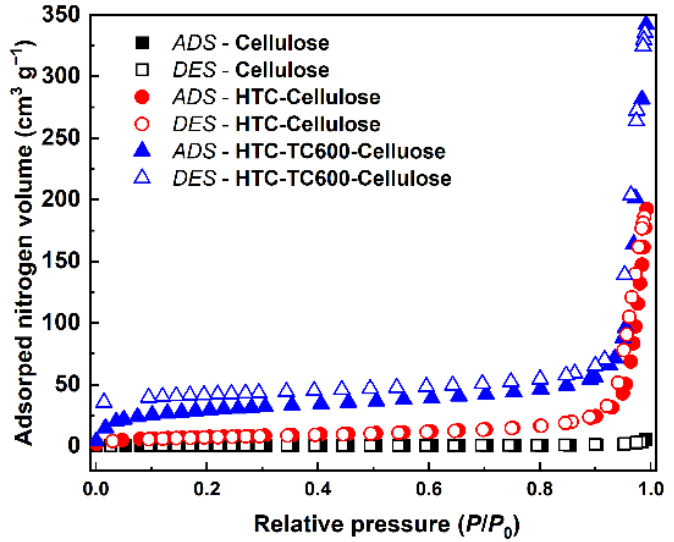
Figure 5. Nitrogen adsorption–desorption isotherms of the tested samples: cellulose, HTC-Cellulose, HTC-TC600-Cellulose. Abbreviations: ADS and DES stands for adsorption and desorption cycle, respectively.